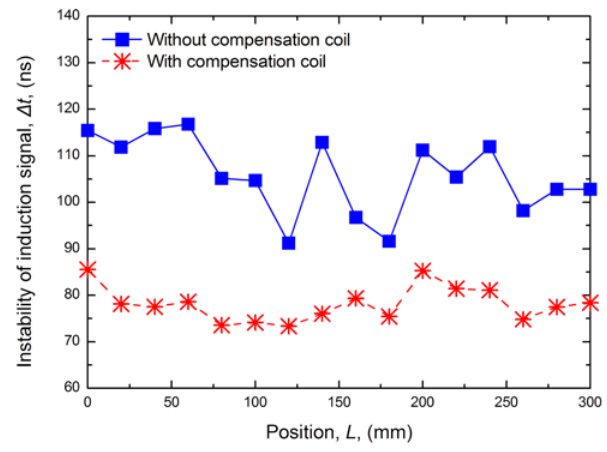
Figure 5. Comparison of induction signal